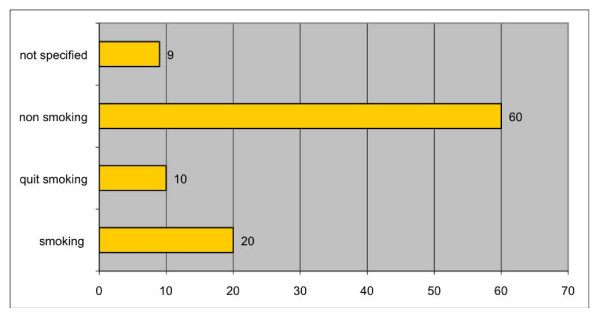
Risk factor smoking.